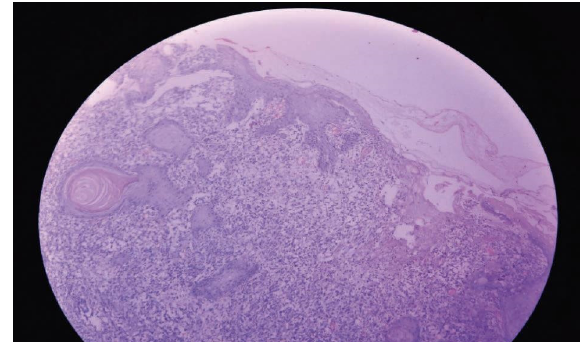
Figure 1: Low power microscopy of the histologic section from the perianal lesion showing skin-covered tissue with a focus on ul- ceration and intense subepithelial mixed infammatory cell in- fltrates (H&E), case 2.